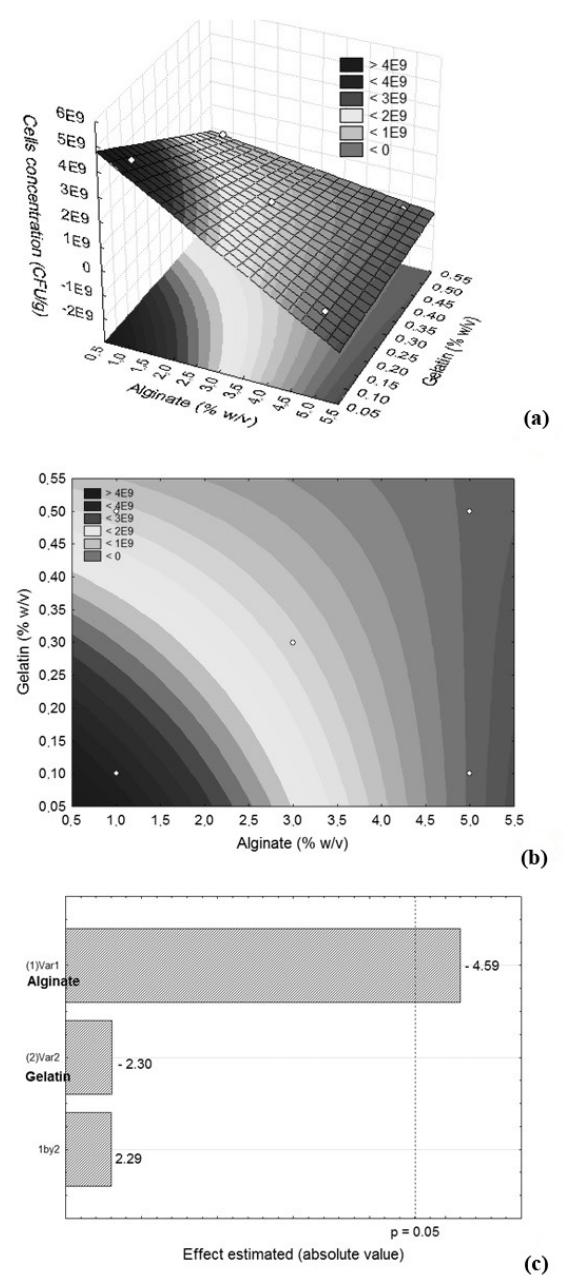
Figure 1 - Response surface (a) , contour curvature (b) and Pareto diagram (c) of viable cell concentration of Lact. rhamnosus as a function of the alginate and gelatin